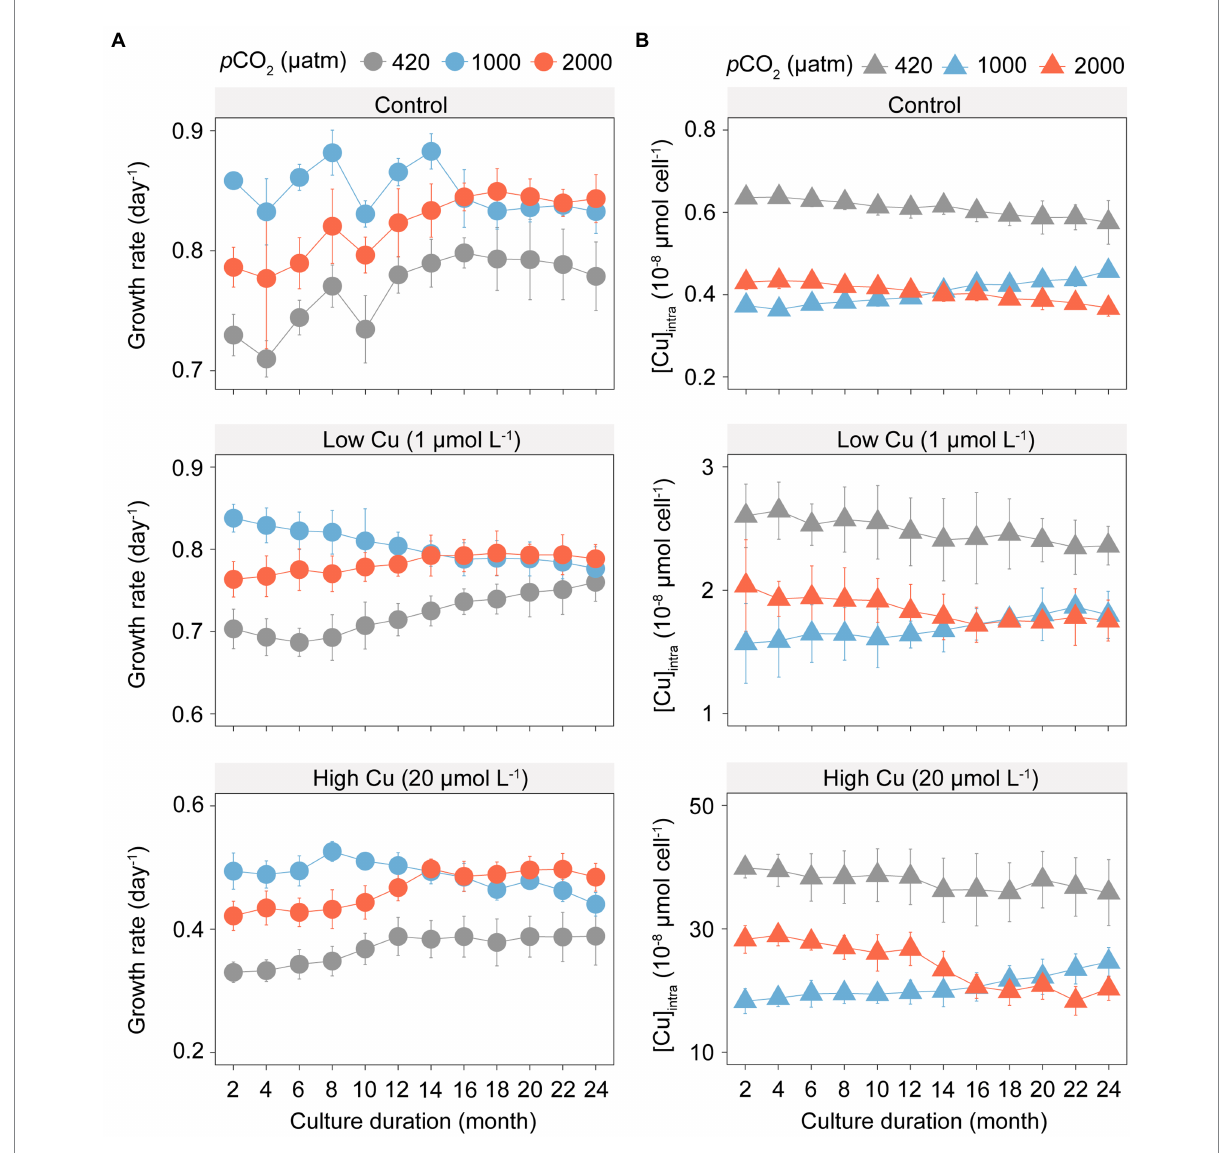
FIGURE 1 Growth rates and intracellular copper concentration of T. pseudonana in the selection experiment under ambient (420 μ atm, grey) and elevated p CO 2 (1,000 μ atm, blue; and 2,000 μ atm, red) with three gradients copper exposure. (A) Changes in growth rate (day − 1 ); (B) Shift in intracellular copper concentration ([Cu] intra ). The symbols represent the means and error bars represent standard deviations of triplicate